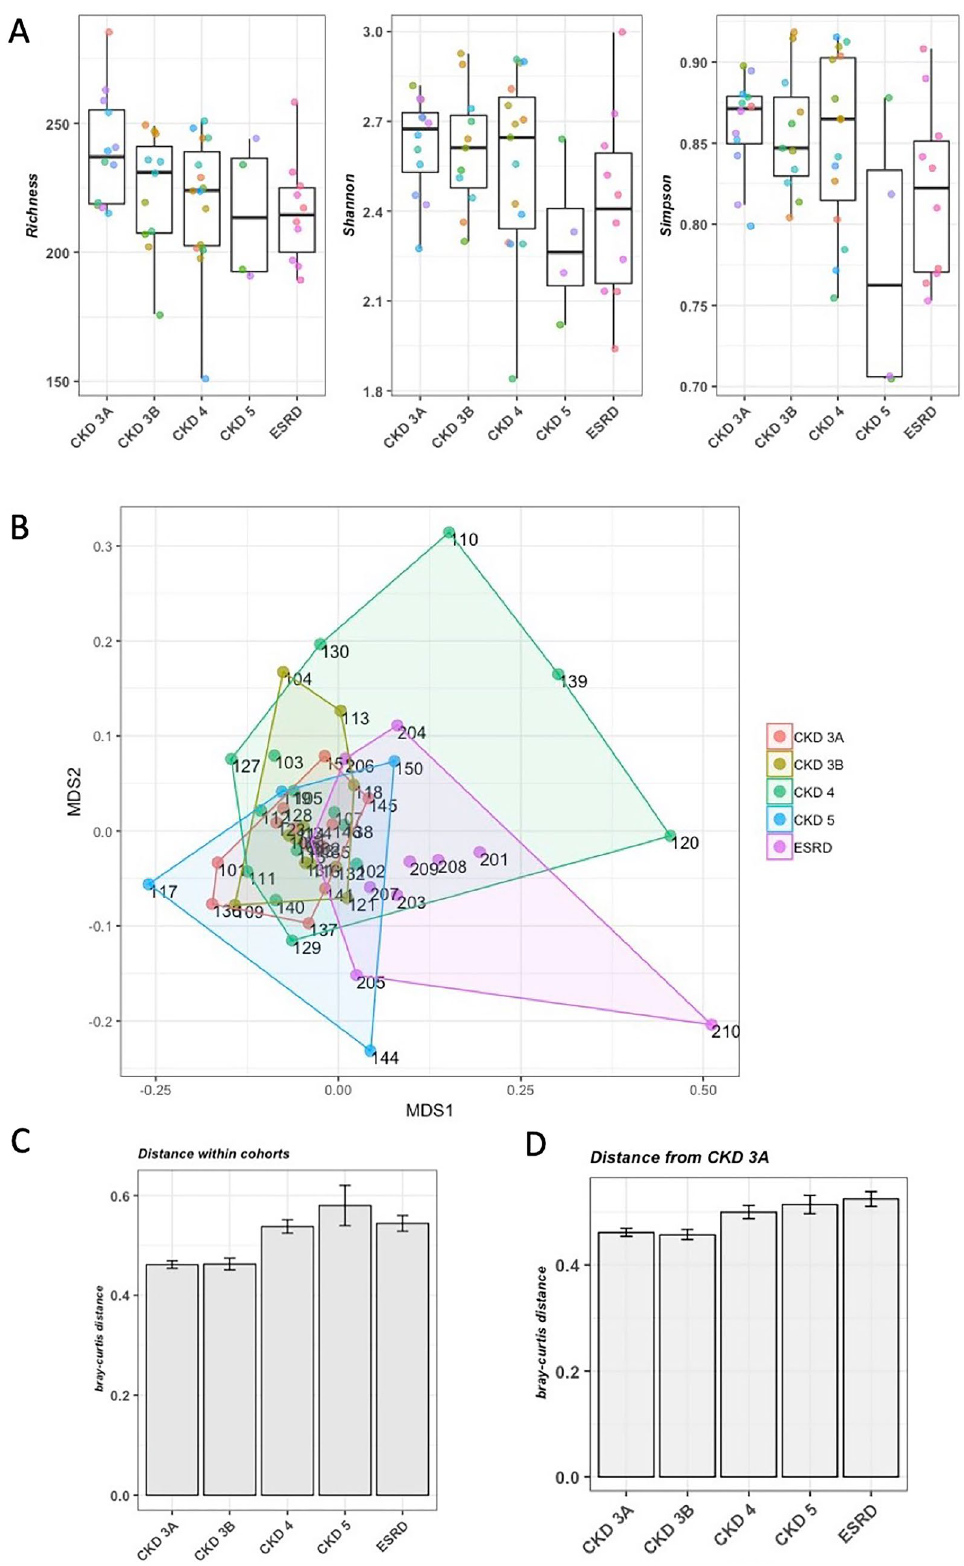
Figure 1. Alpha and beta diversity. ( A ) Richness, Shannon and Simpson index. ( B ) Ordination plot using Bray–Curtis dissimilarity score. Adonis test p-value = 0.057. ( C ) Mean Bray–Curtis distance within the cohorts. P-values were calculated by ANOVA following by Tukey post-hoc test. CKD 3B vs. CKD 3A p = 0.99; CKD 4 vs. CKD 3A p < 0.001; CKD 5 vs. CKD 3A p < 0.001; ESRD vs. CKD 3A p < 0.01; CKD 4 vs. CKD 3B p < 0.001; CKD 5 vs. CKD 3B p < 0.001; ESRD vs. CKD 3B p <